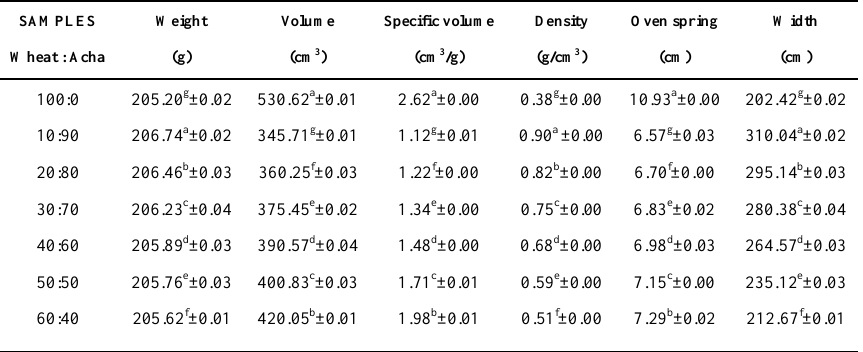
Table 3: Physical Properties of Bread produced from Flour Blends of Wheat and Acha